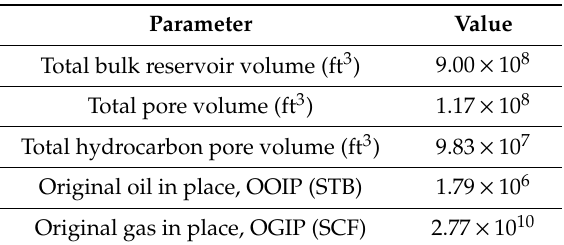
Figure 9. Water (K rw ) and oil (K row ) relative-permeability curves used in simulation model.